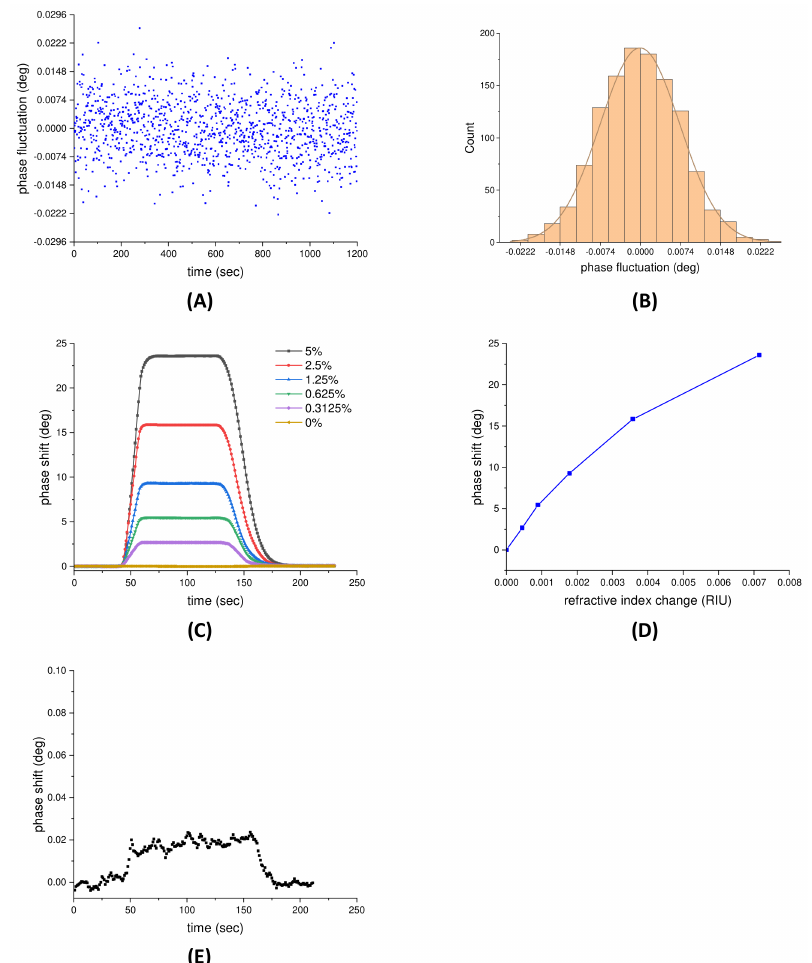
Figure 3. ( A ) The phase fluctuations of the system in DI water environment over a period of 20 min. ( B ) The distribution of the data points in phase fluctuation measurement. An angle of 0.0074 degrees indicates one standard deviation of the phase fluctuation. ( C ) The SPR phase shift measured by the phase-sensitive SPR sensor with respect to time for glycerol–water solution concentrations from 0% to 5%. ( D ) The relationship between the SPR phase shift and the refractive index change. ( E ) The phase shift of 0.3125% × 1 glycerol (8.94 × 10 − 7 RIU) measured by the proposed phase-sensitive 500 SPR